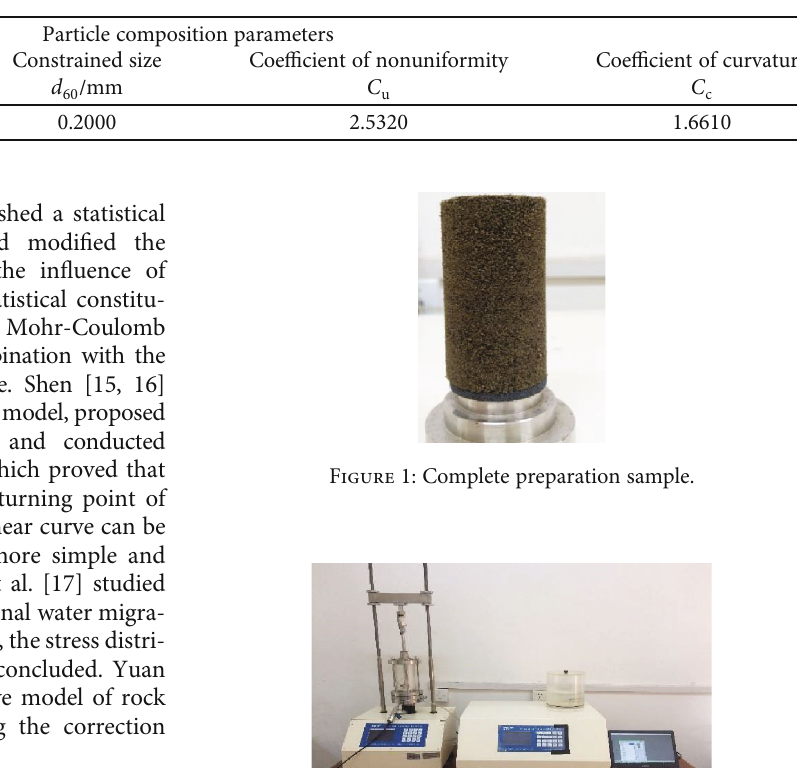
Table 1: Tailing particle group.